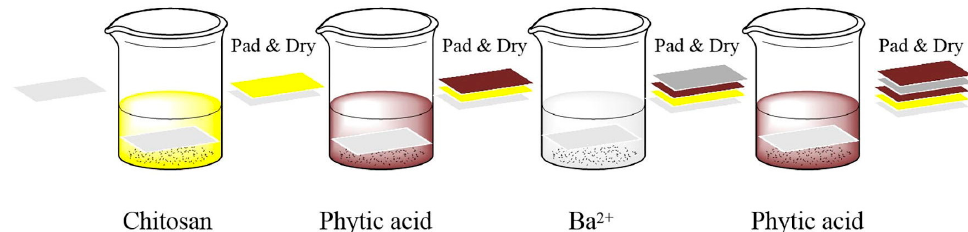
Figure 11. Coating process based on chitosan, phytic acid and barium ion by dip-pad-dry method. Reprinted with permission from [42]. Copyright 2019, Elsevier.